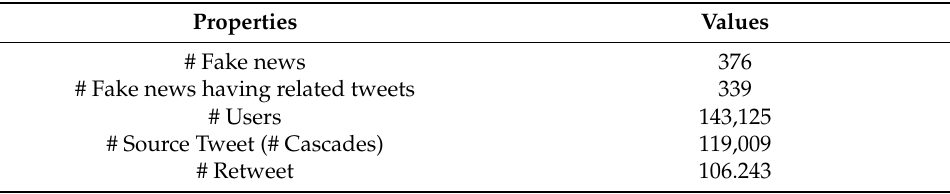
Table 1. The statistics of FakeNewsNet—PolitiFact dataset.